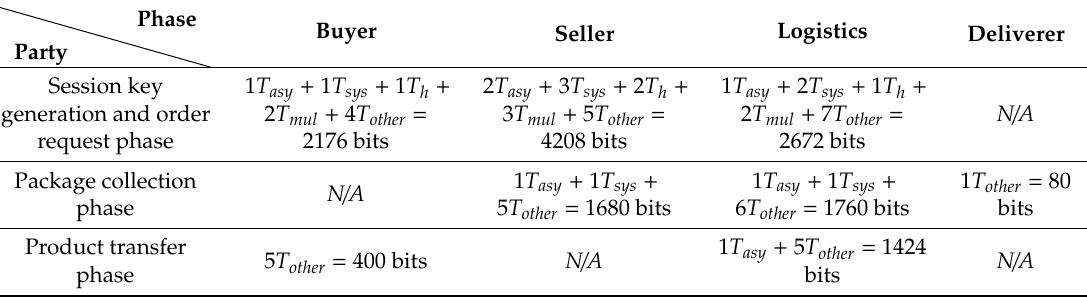
Table 4. Storage cost of the proposed